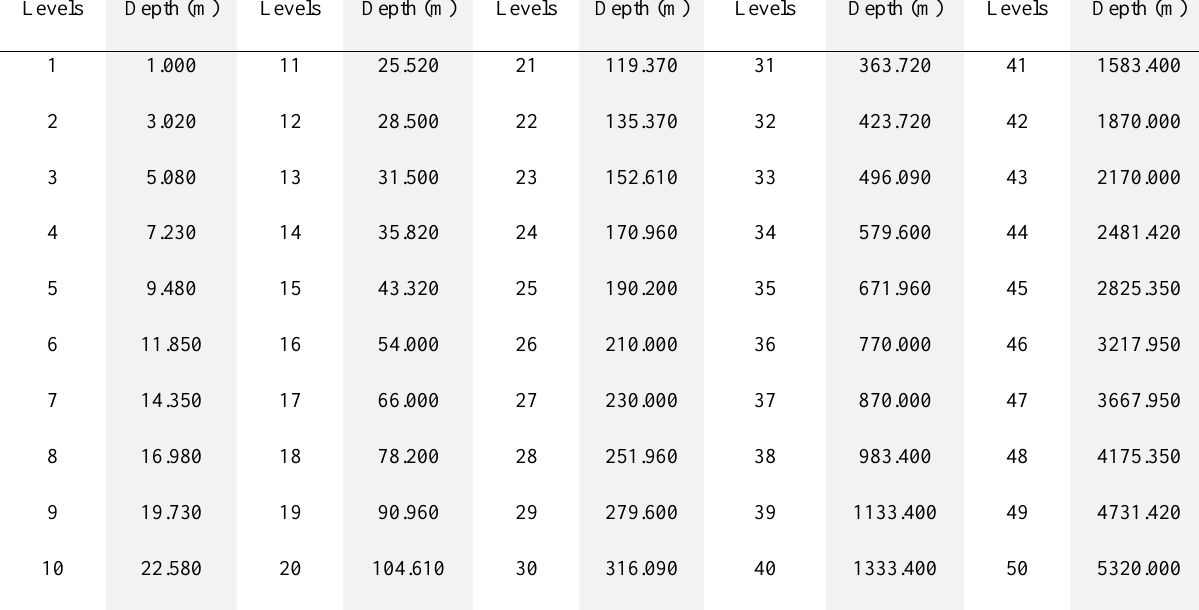
Table 3: Vertical discretization of the water column in our